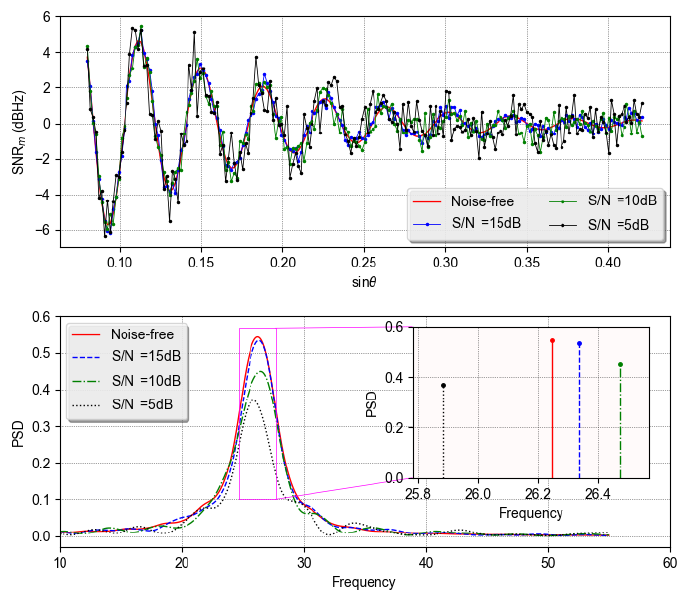
Figure 1. Simulated multipath SNR series with different noise levels and the spectrograms.